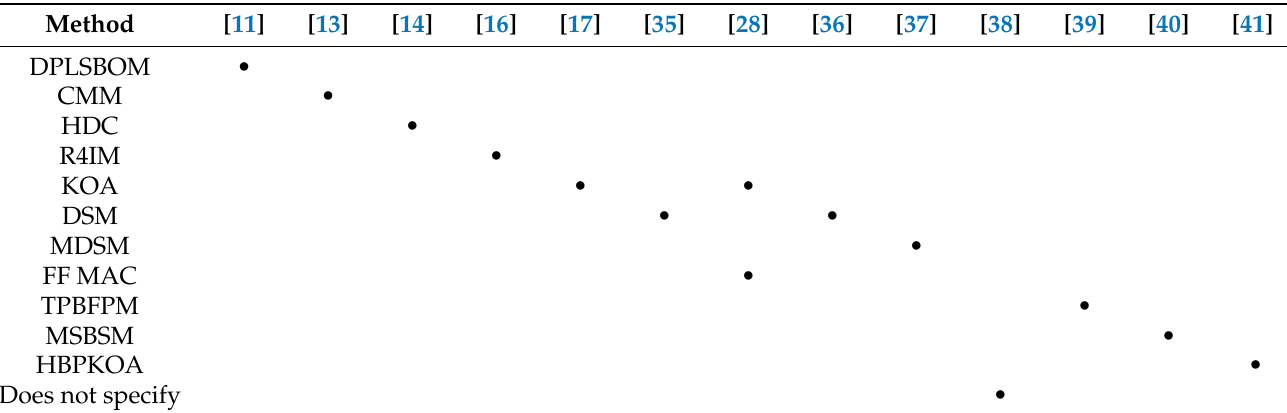
Table 9. Multiplication methods.